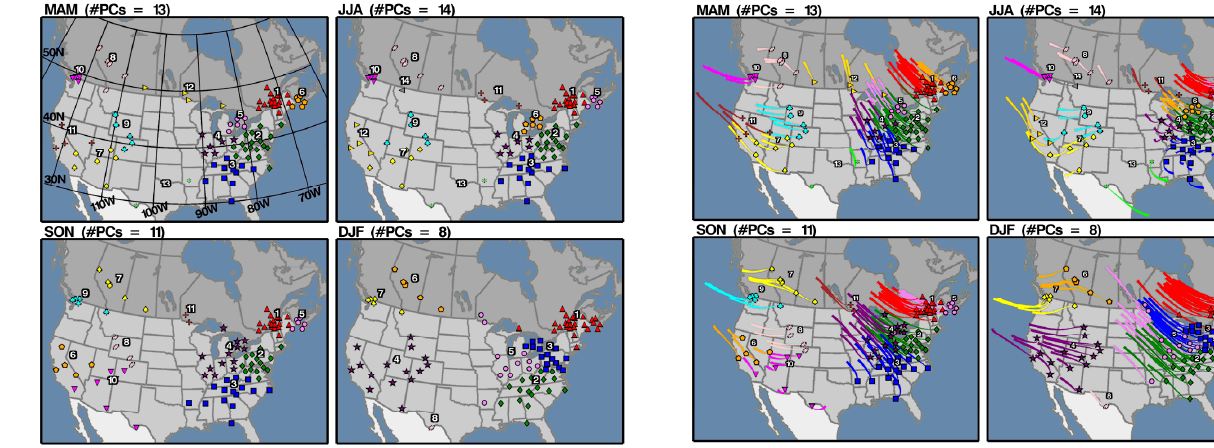
Fig. 1. Results of rotated PCA analysis using six-hour ozone mix- ing ratio averages for the period 1997–2006 for different seasons. The number of regions in the season is shown in the bracket on top of each panel. The seasonal breakdowns are as follows: spring (MAM), summer (JJA), fall (SON), and winter (DJF). Sites that have the same symbols belong to the same region for a given season. See text for more details.